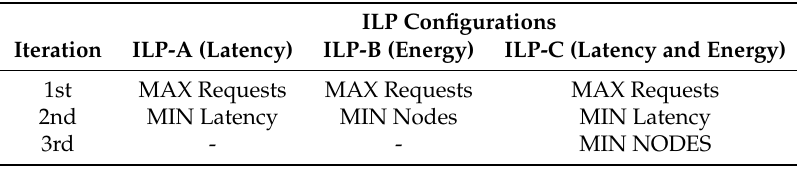
Table 5. The evaluated ILP model configurations.